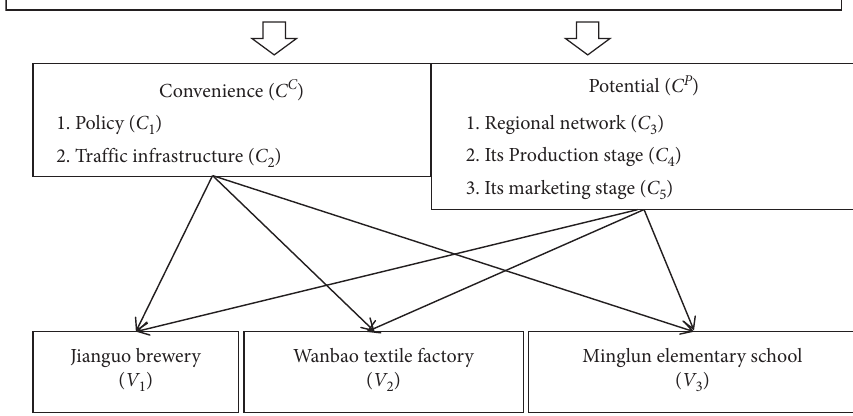
Figure 2: Hierarchy structure of the selection for the startup hub.